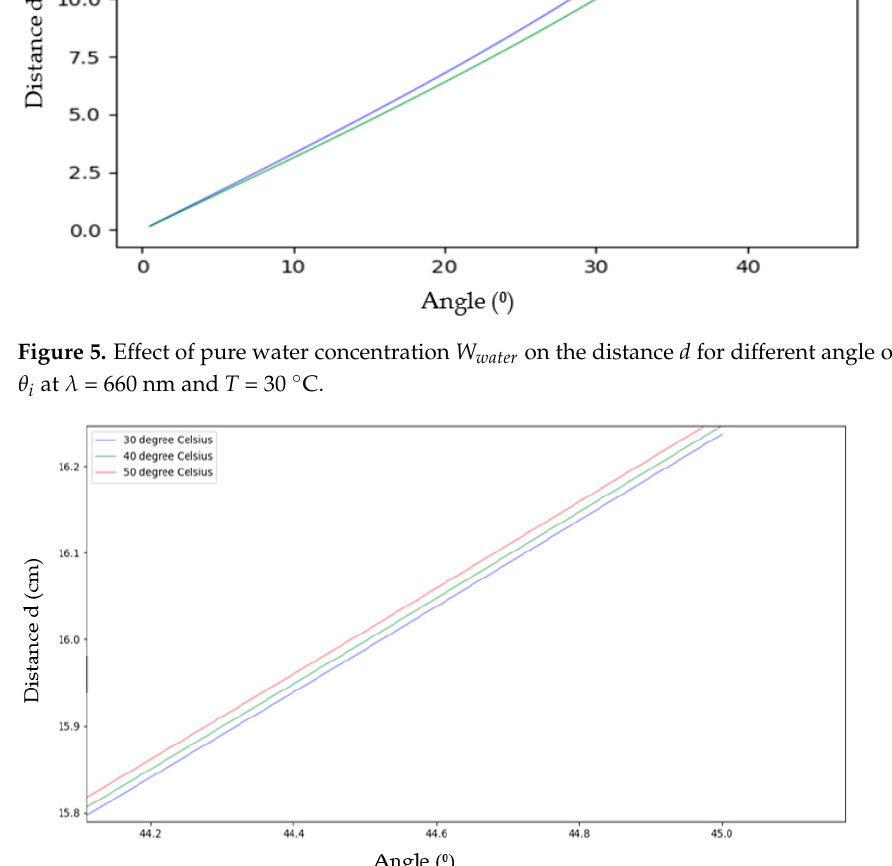
Figure 6. Temperature effect of salt water on the distance d for different angle of incidence θ i at λ = 660 nm and W water = 10 cm.